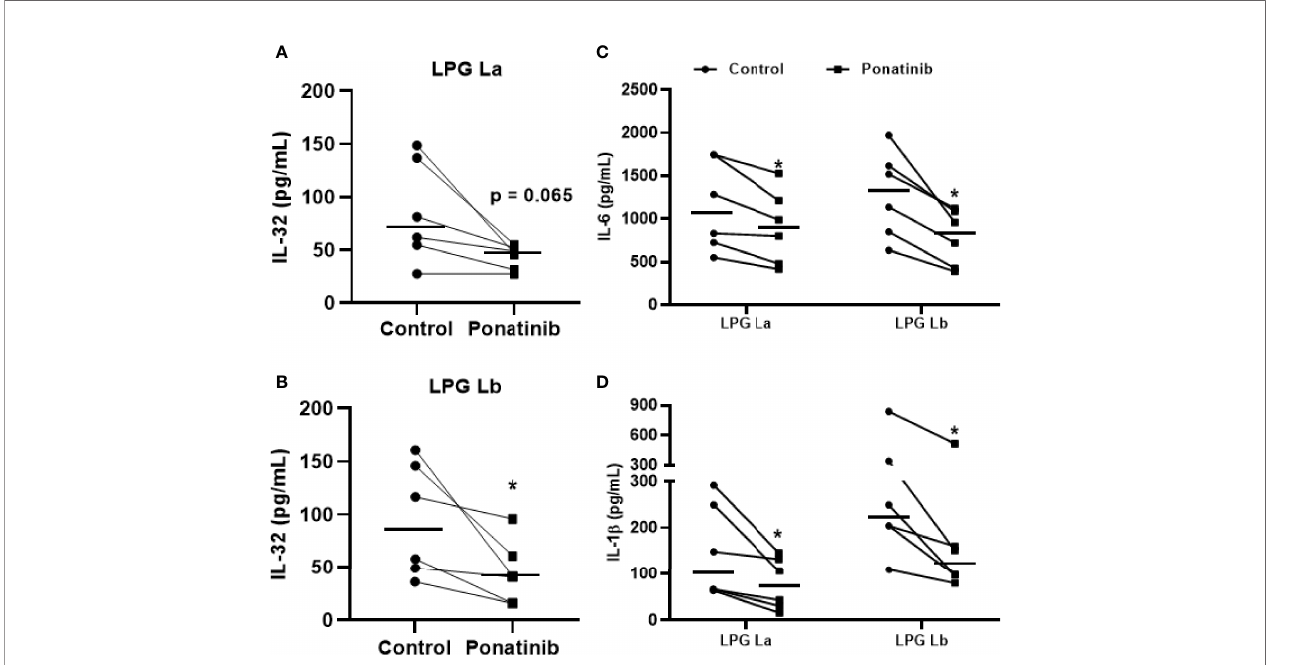
FIGURE 5 | Induction of IL-32 by lipophosphoglycans from Leishmania spp. is dependent on NOD2. PBMCs (5 x 10 5 cells/200 m L) were treated or not with Ponatinib (100 nM) for 1 h and stimulated with LPG (10 m g/mL) from L. amazonensis (La) or from L. braziliensis (Lb) for 24 h. Cell lysates were obtained for IL-32 evaluation by ELISA, and IL-32 production is shown after exposure to LPG from L. amazonensis (A) or L. braziliensis (B) . Supernatants were collected for IL-6 (C) or IL-1 b (D) evaluation by ELISA. Data represent individual and median values (n = 6 donors, evaluated in three independent experiments). *p < 0.05 (vs. control) by Wilcoxon